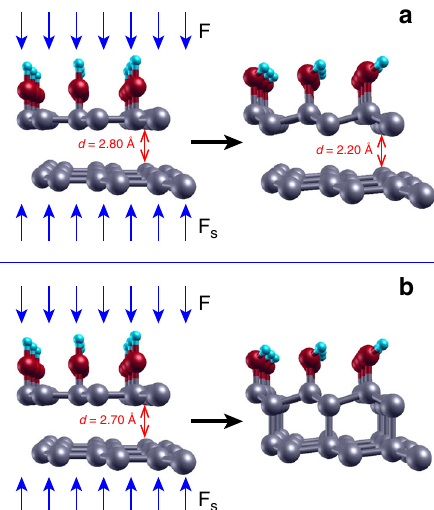
Fig. 4 Geometries for diamondene formation. a Initial ( left ) and converged ( right ) geometries for the case in which the distance between graphene layers is initially set to d = 2.8 Å. Blue , red , and gray spheres represent H, O, and C atoms, respectively. The vertical arrows indicate the forces applied by the PTM (F) and the substrate underneath (F S ). Upon relaxation, the distance d decreases to 2.2 Å, still too long to characterize a covalent interaction between layers. b A second calculation in which the initial distance d was set to 2.7 Å. After relaxation ( right ), the diamondene forms. The C – C interlayer bond lengths become 1.66 Å, and the constrained forces are